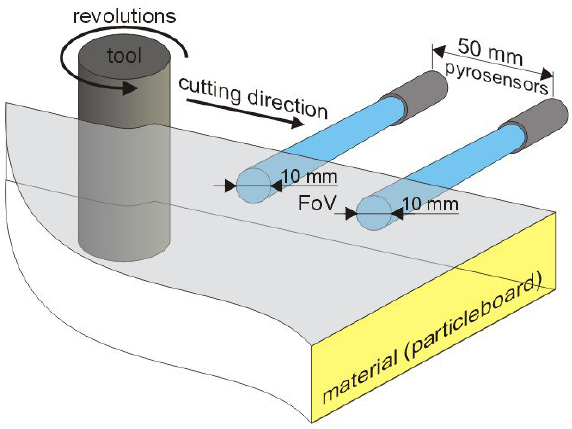
Figure 3. Layout diagram of pyro sensors for temperature measurement.